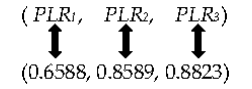
Figure 3. Encoding of fruit fly individual.